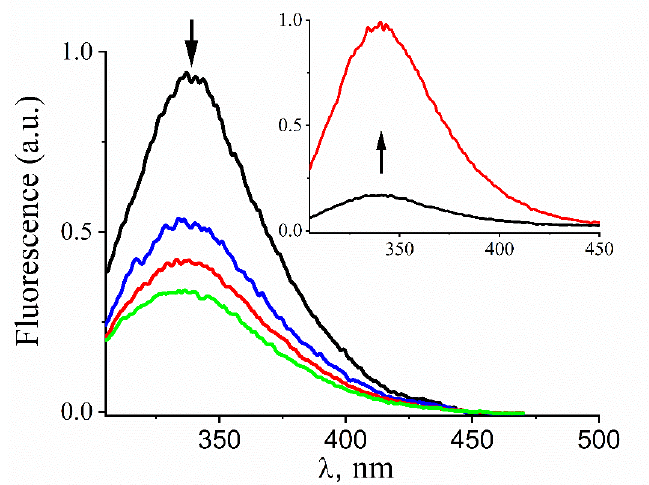
Figure 1. Changes in the intrinsic fluorescence of Prx1C83SC173S upon S-nitrosation and denitrosation. Representative emission spectra ( λ exc. = 280 nm) of reduced Prx1C83SC173S (5 µ M) before (black trace) and 2 (blue trace), 5 (red trace), and 10 min (green trace) after addition of GSNO (nitrosoglutathione) (400 µ M). Inset: representative emission spectra ( λ exc. = 280 nm) of S-nitrosated Prx1C83SC173S (5 µ M) before (black trace) and 10 min (red trace) after addition of glutathione (400 µ M). The rows indicate the temporal spectral changes. The incubations were performed in phosphate buffer (50 mM) containing DTPA (diethylenetriaminepentaacetic acid) (0.1 mM), pH 7.4 and 25 °C.